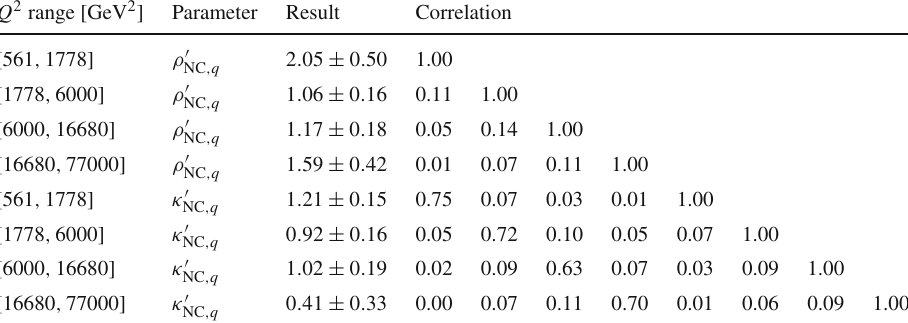
Table 14 Results for the ρ (cid:6) NC , e and κ (cid:6) parameters NC , e determined at different values of Q 2 . The Q 2 range of the data selection, and the correlation coefficients of the fit